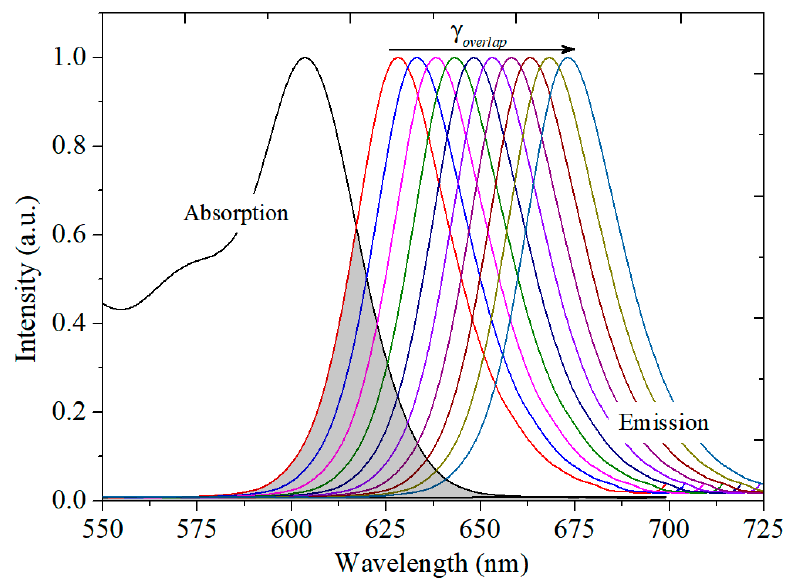
Figure 9. The overlap coefficients between the absorption and emission cross-sections with different peak wavelengths.